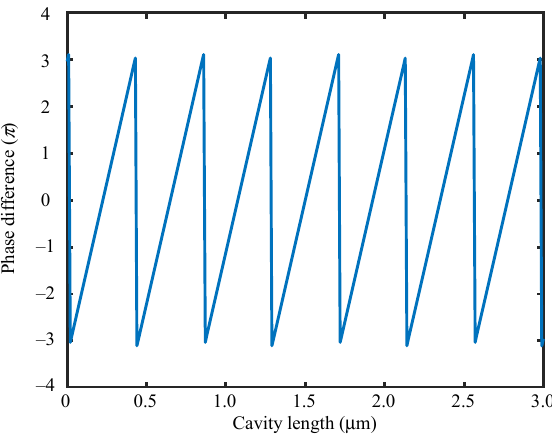
Fig. 2 Diagram of the cavity